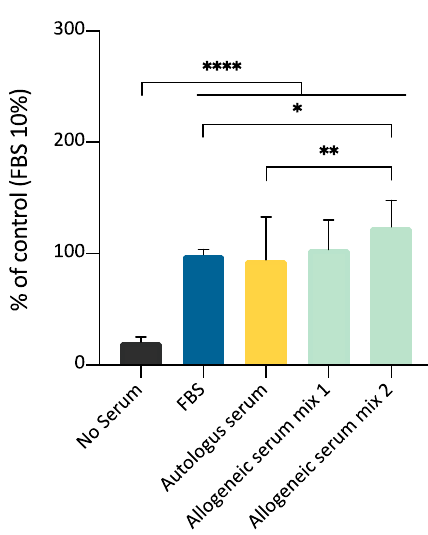
Figure 10. Comparison between allogeneic serum, autologous serum, and FBS as medium supplements for ADMSCs growth, by MTT assay (5000 cells/well; 10% supplementation; 72 h). Both autologous serum and allogeneic serum mix supplementation can substitute FBS for ADMSCs culture. Statistically significant differences are indicated as follows: * p ≤ 0.05, ** p ≤ 0.01, **** p ≤ 0.0001.